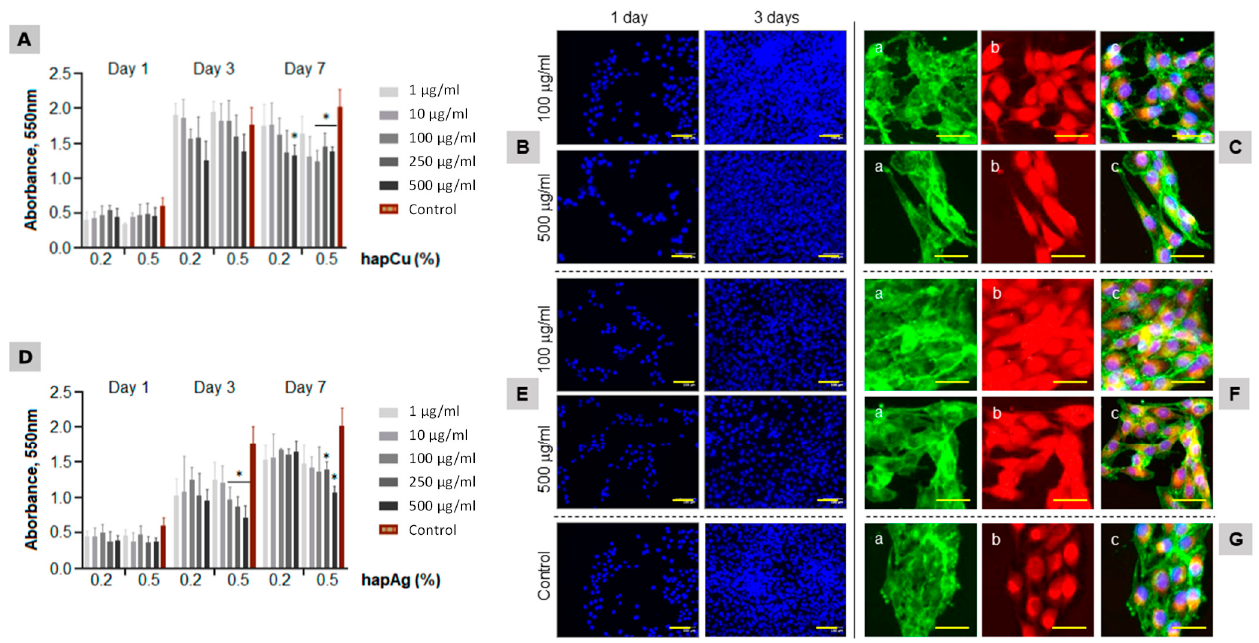
Figure 8. Behavior of MG63 osteoblastic cells exposed to hapCu ( A – C ) and hapAg ( D – F ) powders (1 to 500 µ g/mL). Control (( G ); standard tissue culture plate). Cell viability/proliferation (( A , D ); days 1, 3 and 7) and cultures stained for the nuclei (( B , E , G ); blue, days 1 and 3), F-actin cytoskeleton staining (( C ( a ), F ( a ), G ( a )), green, day 3), mitochondria tracking (( C ( b ), F ( b ), G ( b )); red, day 3) and triple staining (( C ( c ), F ( c ), G ( c )); day 3). * Significantly different from control, p ≤ 0.05. Bar = 50 μ m.